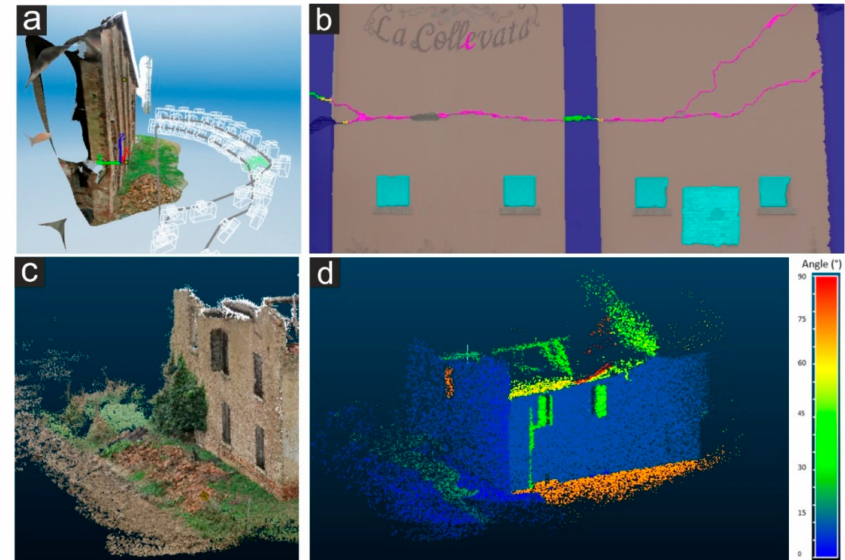
Figure 1. Damages identified from unmanned aerial vehicle (UAV)-derived point clouds and from object-based image analysis (OBIA) processing. ( a ) Inclination in walls, ( b ) openings (turquois), cracks (magenta), and damage crossing beams, ( c , d ) detailed point cloud and segment orientation angles [adapted from